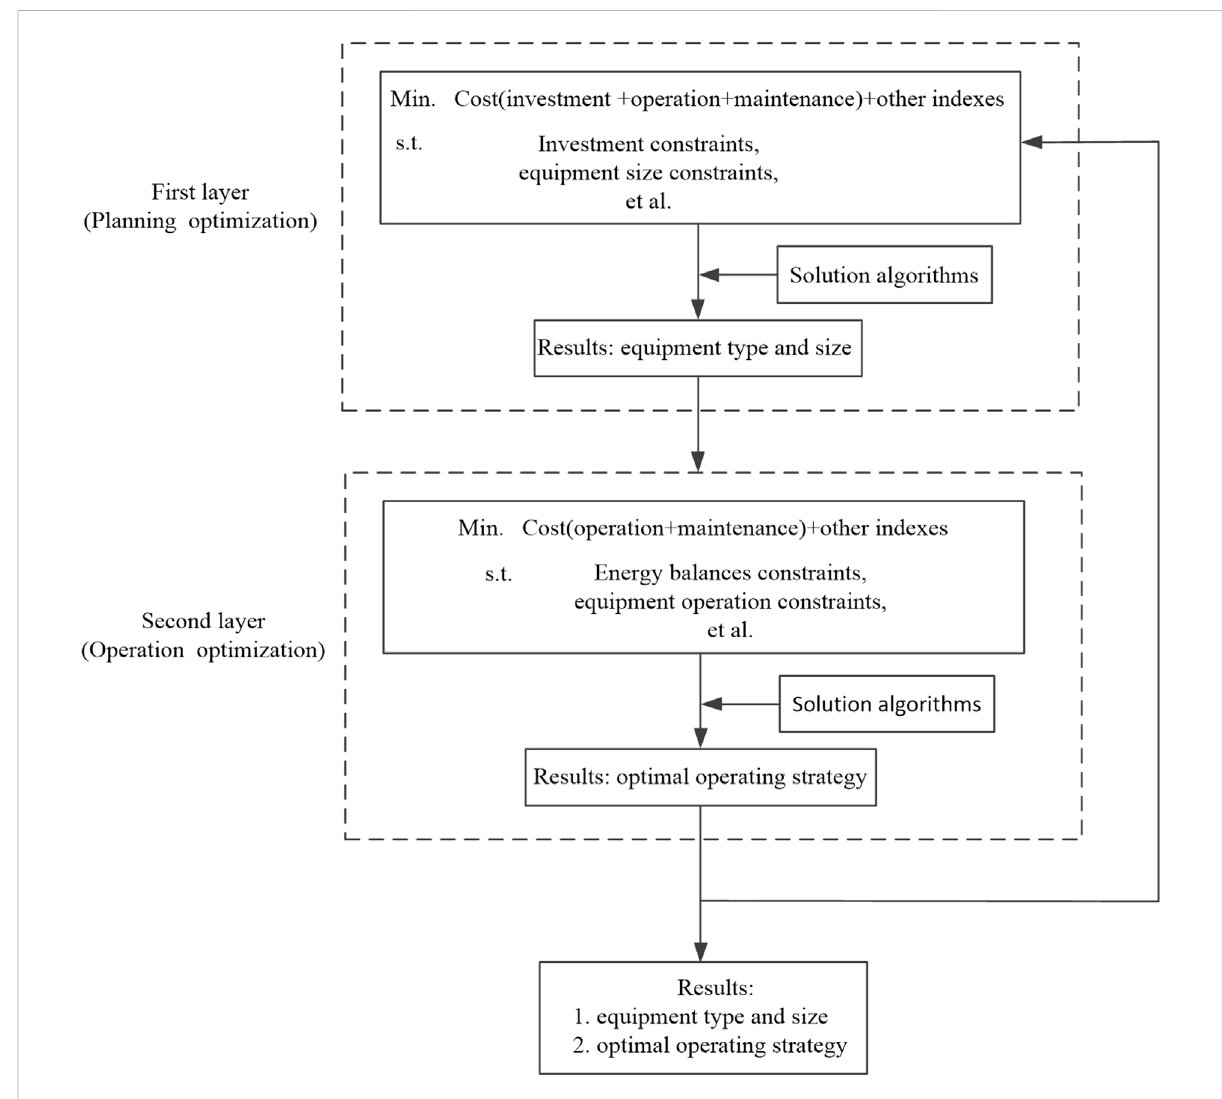
FIGURE 4 Centralized architecture for RE-HES con fi guration